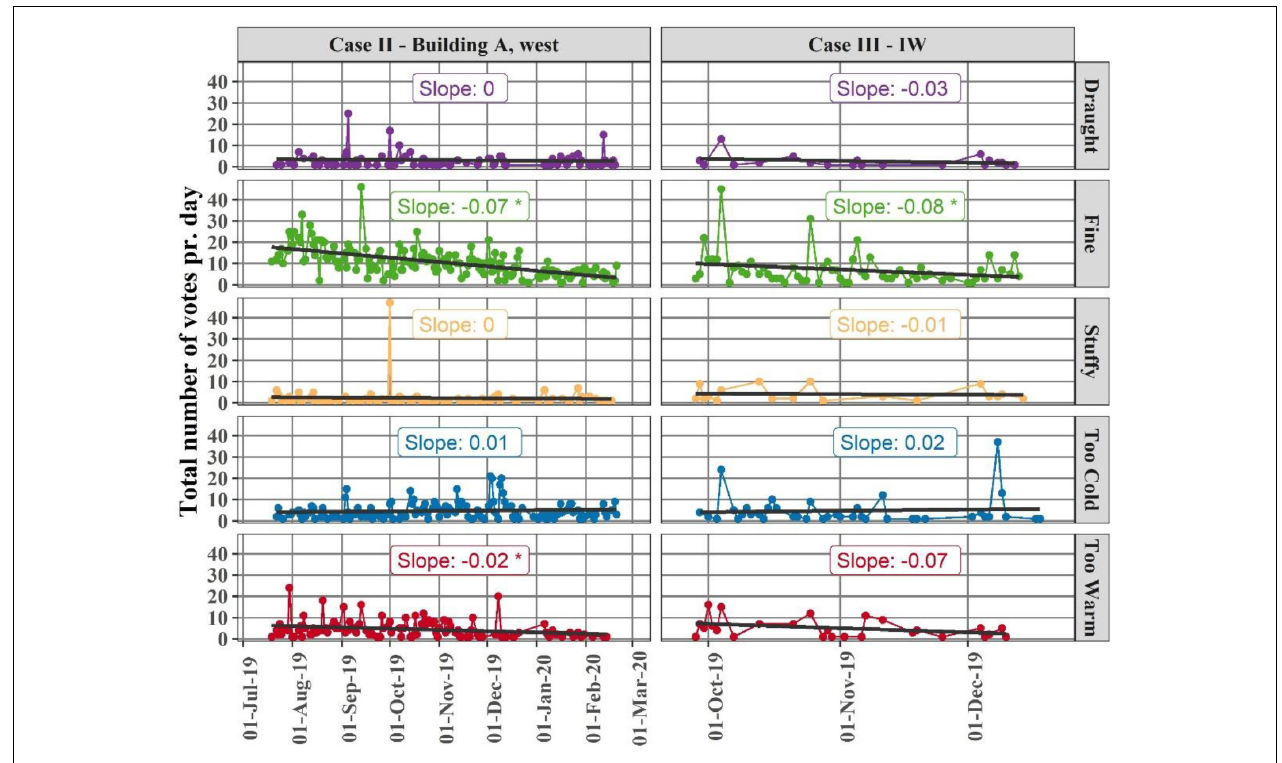
FIGURE 5 | The total number of votes per day for case II and III for each vote type. The value and significance (denoted with * if p -value < 0.05) of the slope are displayed for the trend lines. The slope was characterised as the overall mean of the total number of votes per